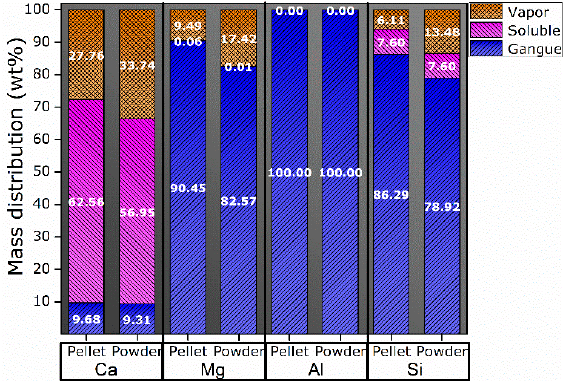
Figure 15. Mass distribution of the elements among three forms, i.e., Vapor: vaporized during reduction; Soluble: water-soluble form in the reduced product; Gangue: water-insoluble form in the reduced product.